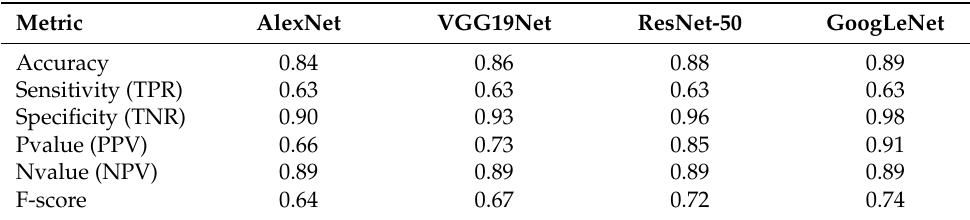
Figure 9. The operations of data augmentation applied to the monkeypox dataset. Data augmentation was used for the training and validation sets only. Table 5. Evaluation of the features extracted using four deep neural networks and the developed multi-layer neural